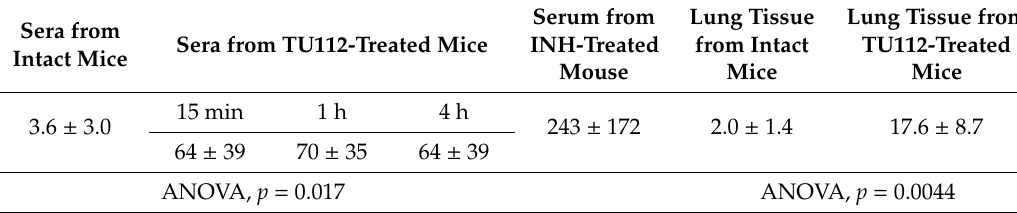
Table 3. Final dilutions of serum and lung homogenate samples providing inhibition of mycobacterial growth